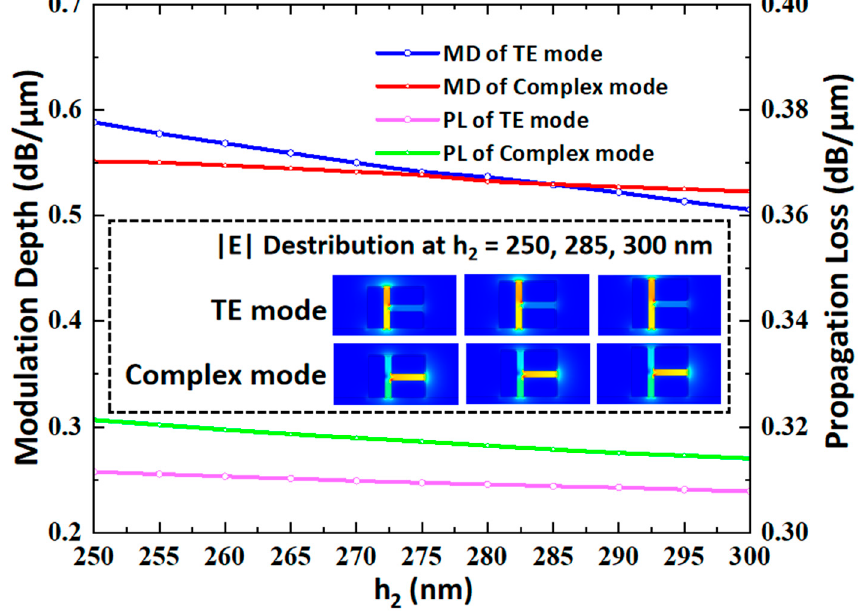
Figure 11. MD and PL as a changing relationship of h 2 for TE mode and complex mode.